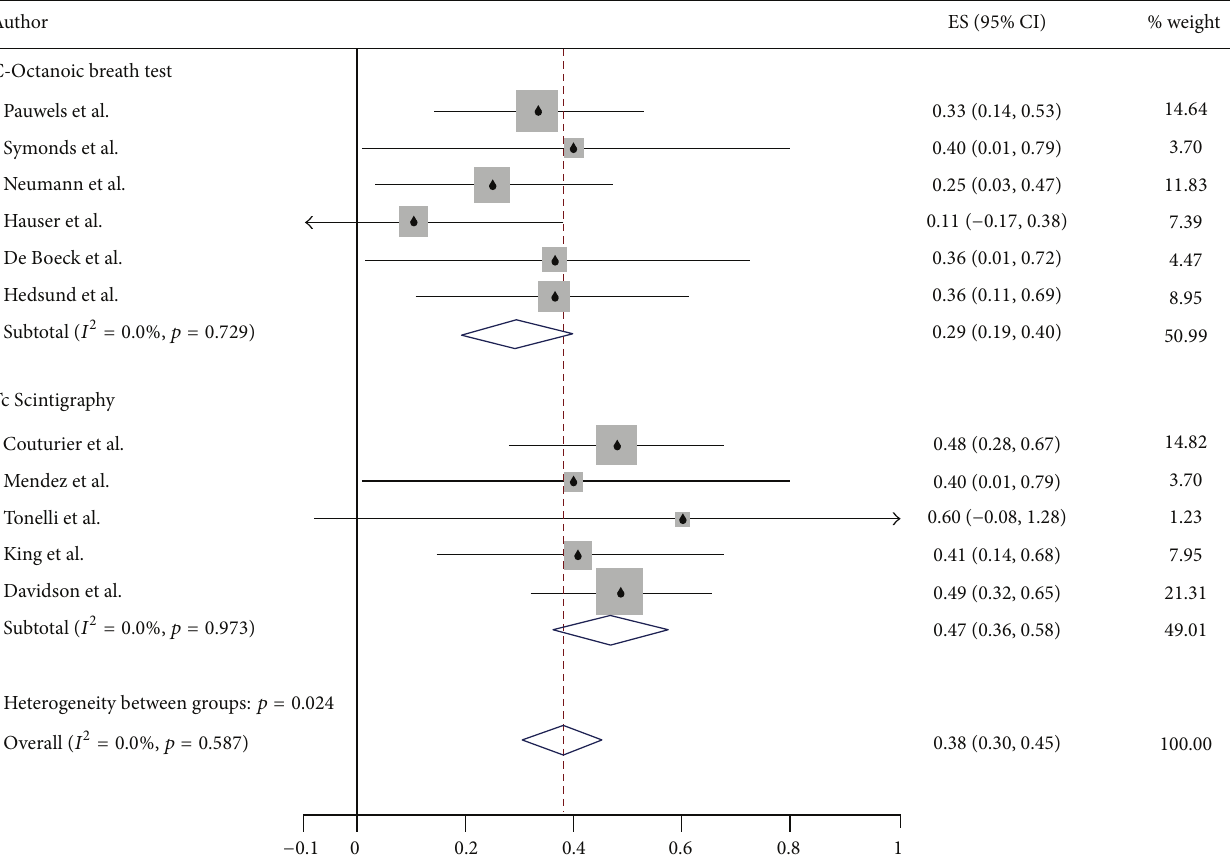
Figure 2: Forest plot graph for frequency of gastroparesis in cystic fibrosis, divided by measuring